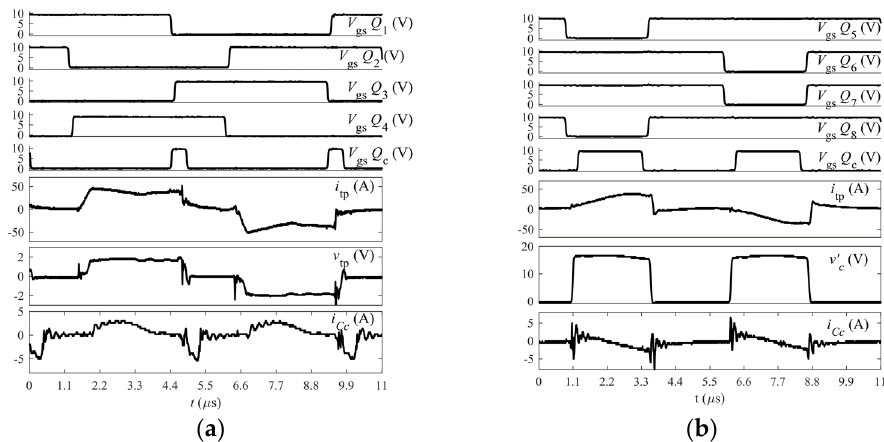
Figure 16. Experimental waveforms for each SM in ( a ) buck and ( b ) boost-mode.